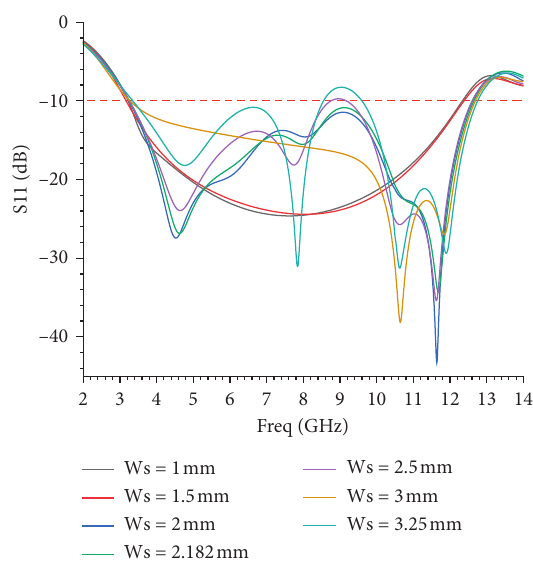
Figure 7: Effect of W s variation on the reflection